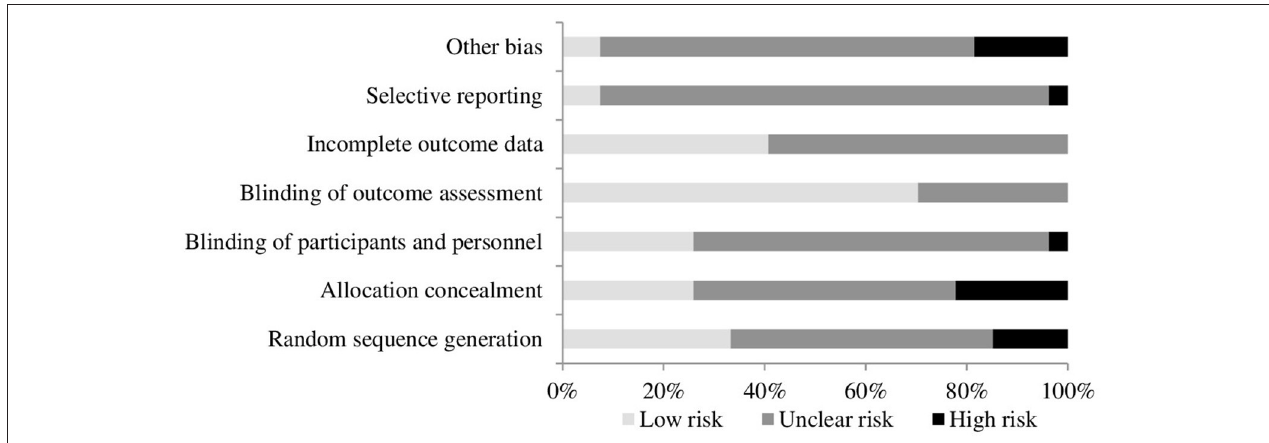
FIGURE 2 | Quality assessment across included studies.